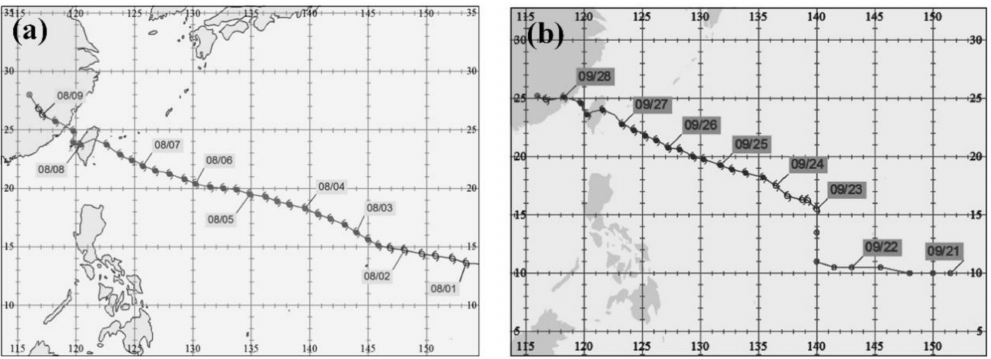
Figure 7. Typhoon tracks of ( a ) Soudelor in 2015 and ( b ) Megi in 2016.